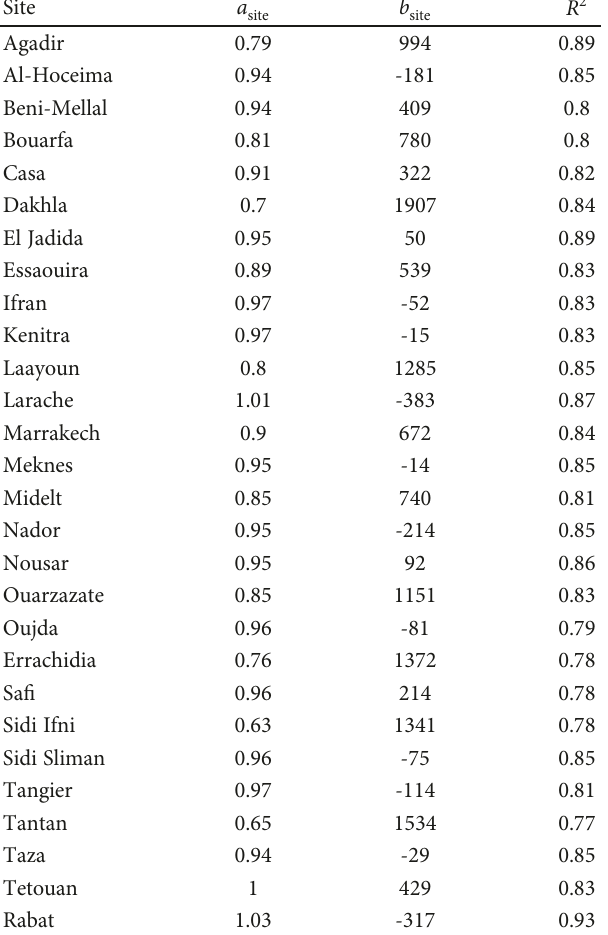
Table 5: Correlation equations for the daily values of the spectral components of solar radiation (Wh/m 2 ) in function of global solar radiation H (Wh/m 2 ) for the three sky conditions.